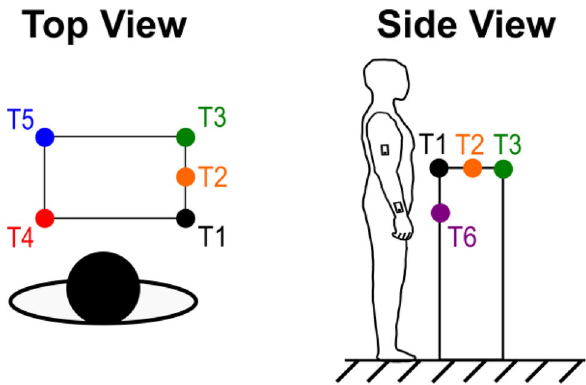
Figure 3. Schematic of the first task. Starting with the arm at the side, each healthy participant reached out towards target one (T1), held the reach for several seconds, then returned the arm to the side. Each participant repeated this movement sequence for the remaining targets (T2 to T6) in sequential